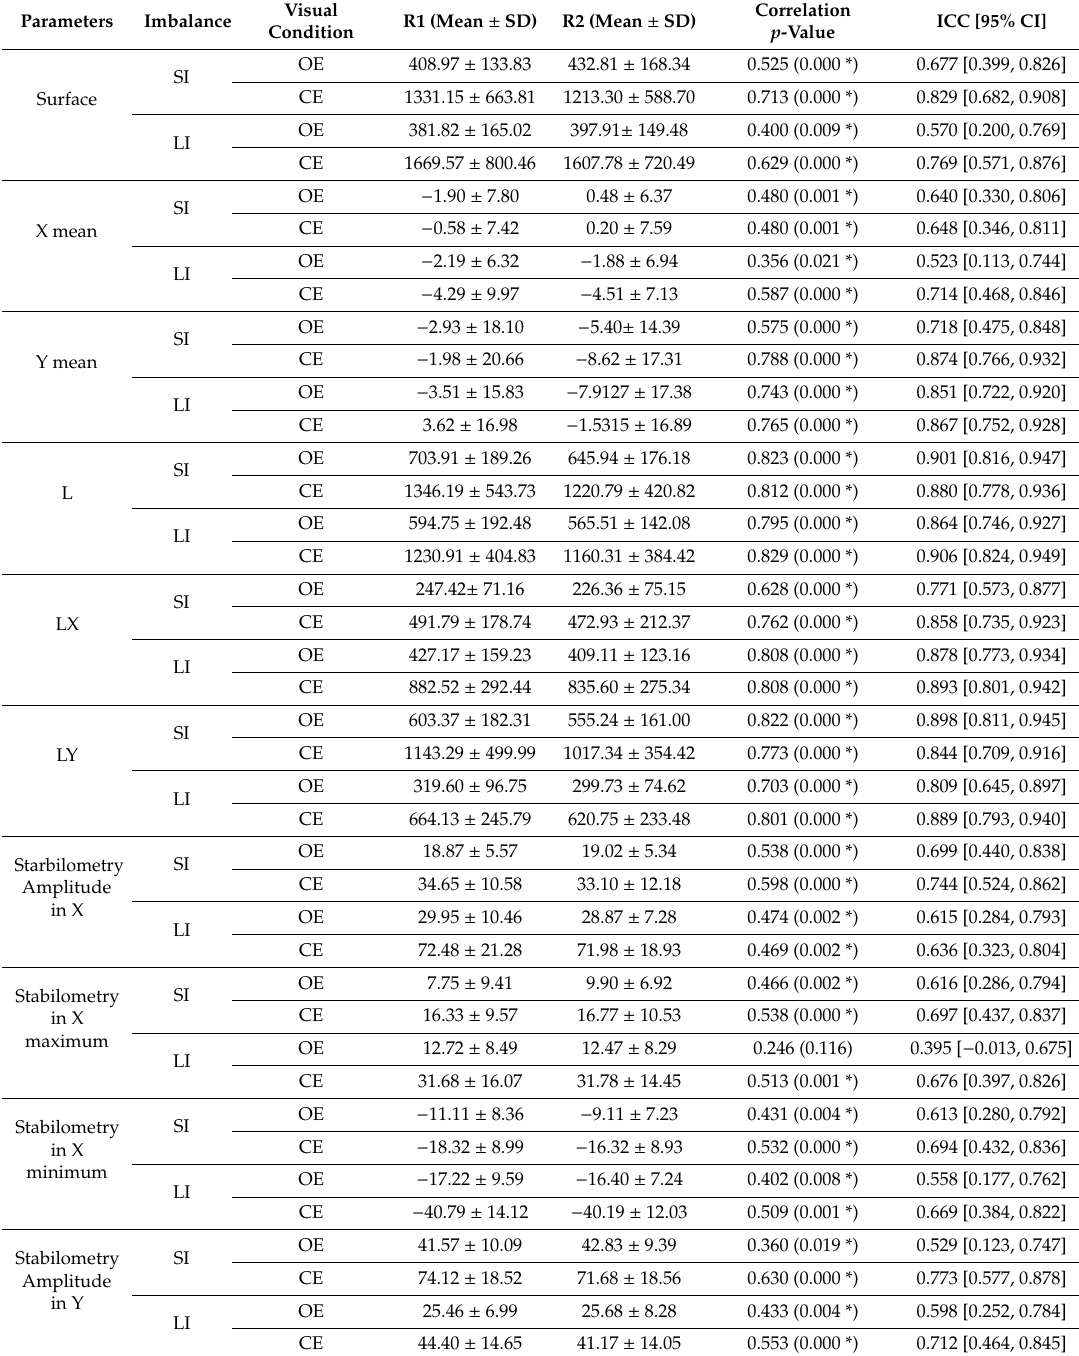
Table 4. Stabilometric results of stabilometric parameters in dynamic condition. Anterior–Posterior and Medial–Lateral